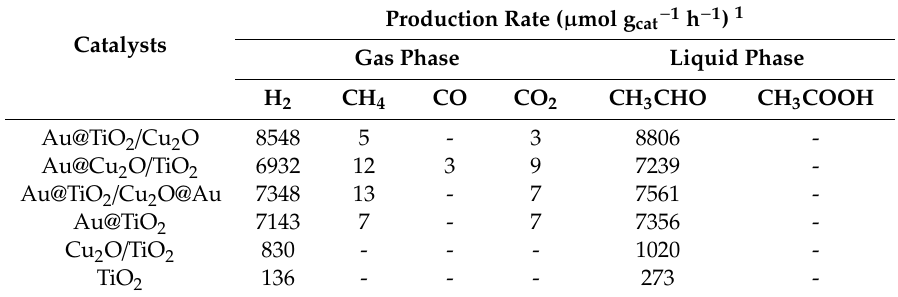
Table 4. H 2 production via photoreforming of ethanol on the catalysts under simulated solar light.